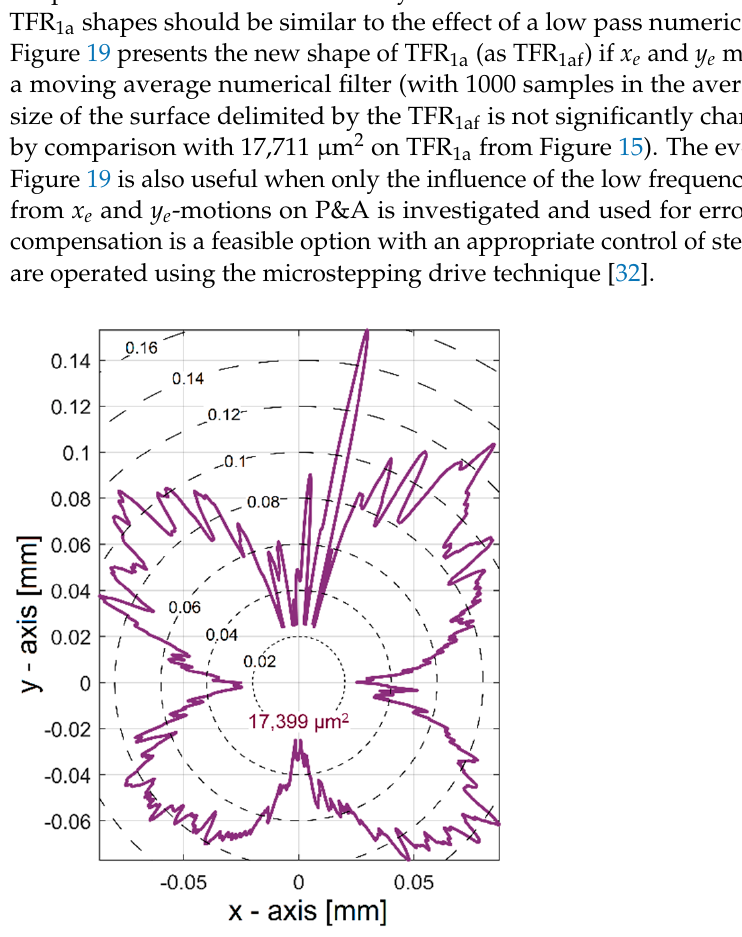
Figure 19. The evolution of TFR 1a from Figure 15 with a low pass filtering of x e and y e (as TFR 1af ). If the accuracy describes how close the real trajectory is to a desired circle (or how close the shapes of TFR 1 , TFR 1a and TFR 1af by a point are), the precision describes the repeatability of real trajectories, each trajectory being generated using a complete cycle (period) of x and y -motions, partially described in Figure 4. The best way to compare these real trajectories is to use the comparison between trajectories fitting residuals related to a circle with a smaller radius than the radius of least square circle (defined similarly to TFR 1a ) but using low pass filtered x and y -motions (as TFR 3af ). A perfect coincidence of real trajectories should produce a perfect coincidence of TFR 3af trajectories. Figure 20 presents the evolution of TFR 3af for five successive real trajectories (TFR 3af1 ÷ TFR 3af5 ) and the evolution of TFR 1a .